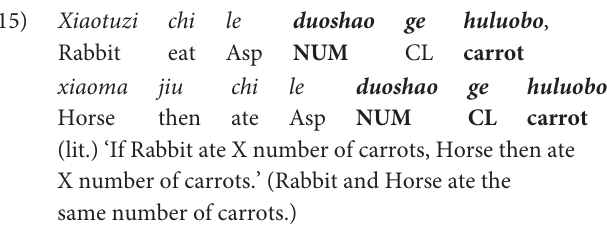
(lit.) ‘If Rabbit ate X number of carrots, Horse then ate X number of carrots.’ (Rabbit and Horse ate the same number of